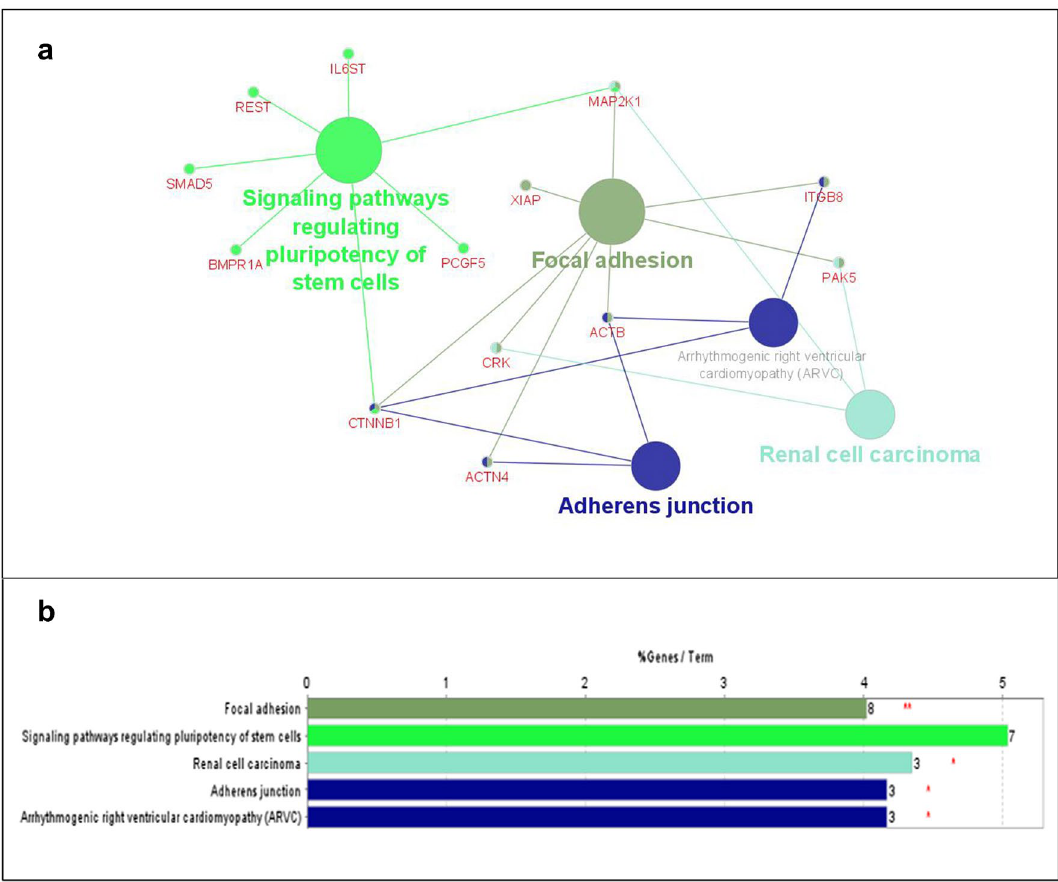
Figure 6. Enriched KEGG pathway for miR-548l target genes in ClueGO and CluePedia. ( a ) Enriched KEGG pathways for miR-548l targets. The node size represents the term enrichment significance ( b ) Bars represent the number of genes associated with each term/pathway. Percentage of genes per term is shown as bar